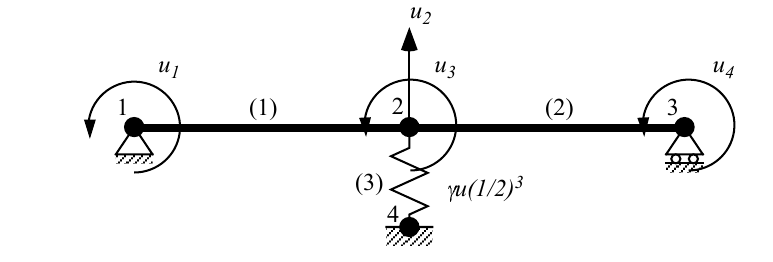
Fig. 2. Finite element model of the beam with cubic